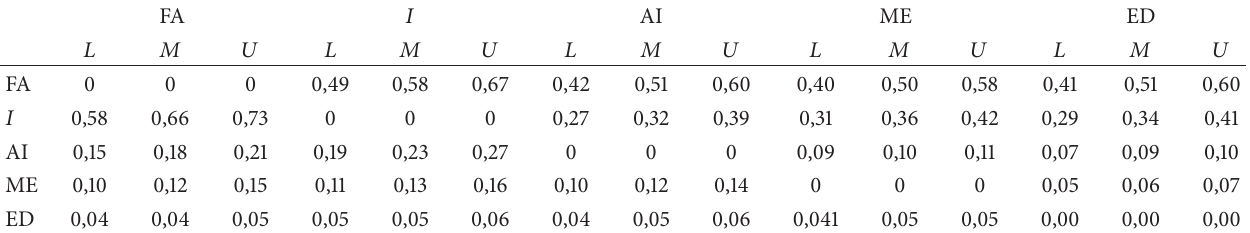
Table 10: Pairwise comparison for 𝑊 33 .